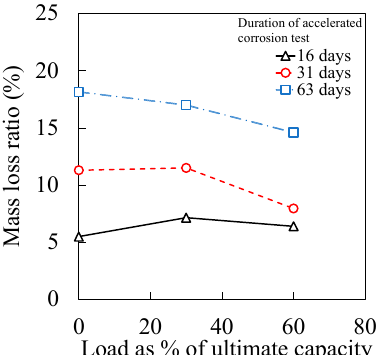
Figure 6. Sustained load versus mass loss ratio under different durations of accelerated corrosion test.